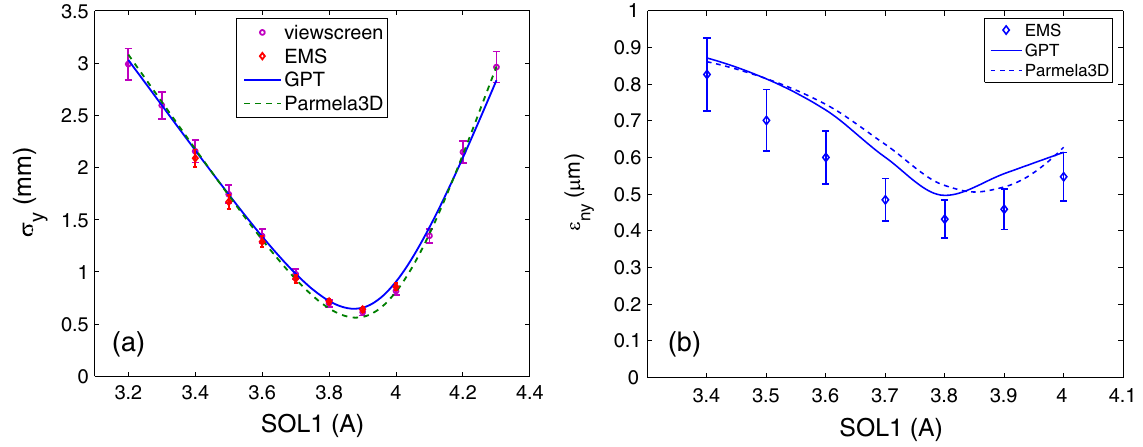
FIG. 16. (Color) Comparison of vertical rms beam size (a) and normalized rms emittance (b) at the location of the measurement z ¼ 1 : 244 m vs solenoid excitation current for 20 pC bunches.